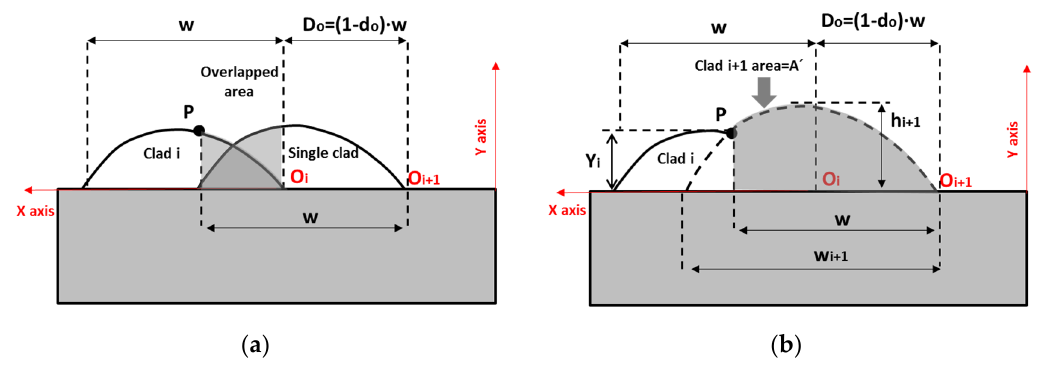
Figure 3. Geometrical model. ( a ) First iteration clad; ( b ) adjacent clad i + 1: second-degree parabola formed with the single clad area and the overlapped area of the previous clad i .